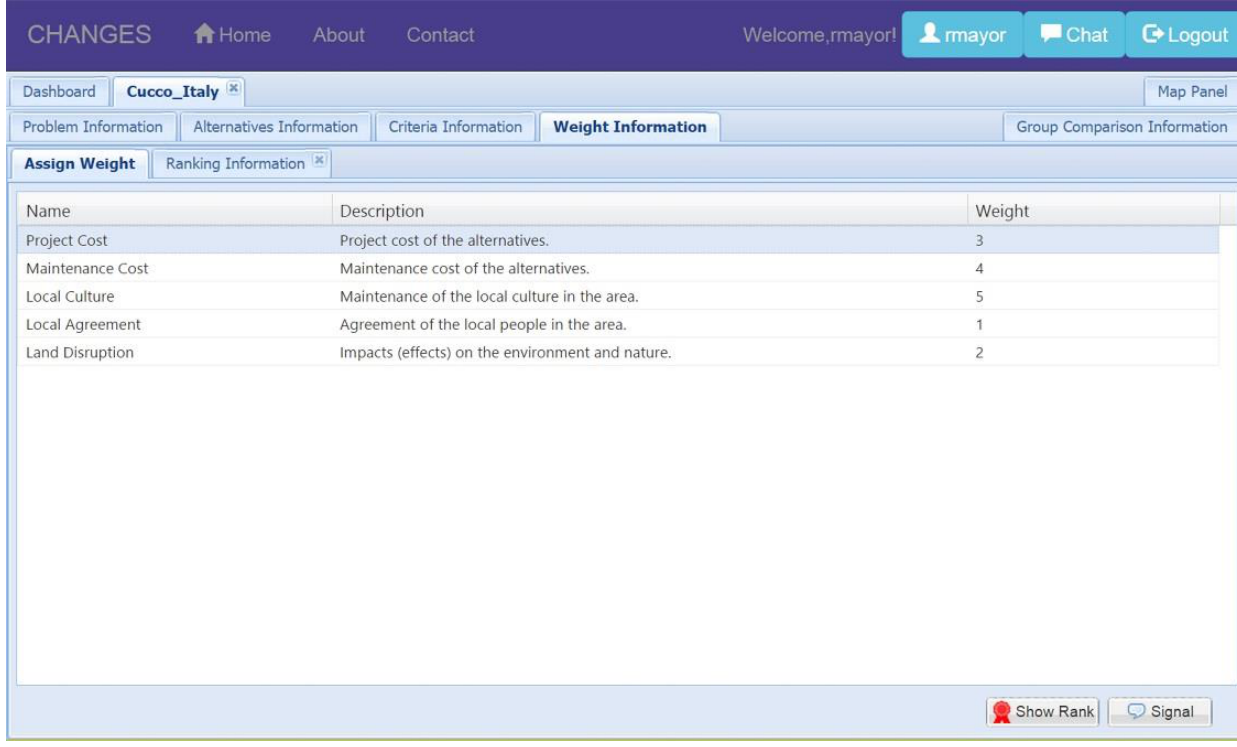
Figure 14. An example assigned weight set by the